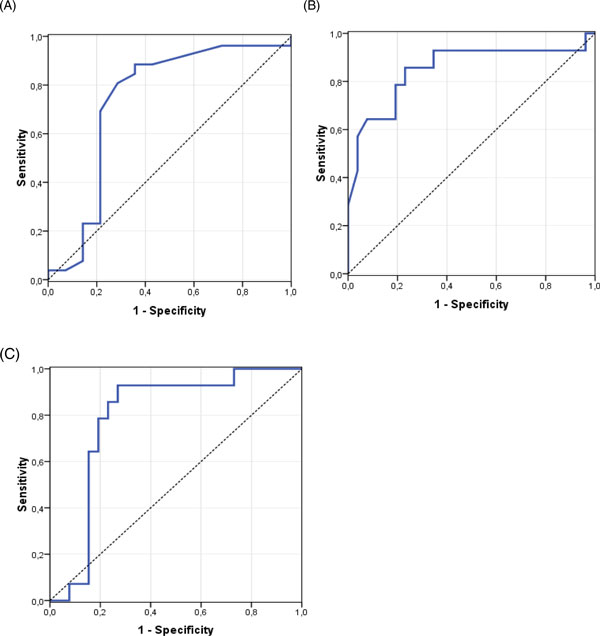
ROC curves. (A) Highest IAP. (B) Lowest APP. (C) Lowest PDRICG.